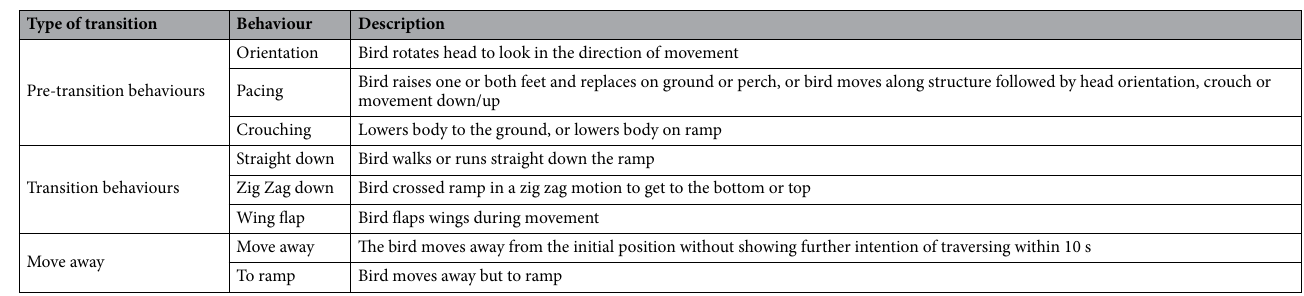
Table 6. An ethogram of behaviours of focal birds during up and down